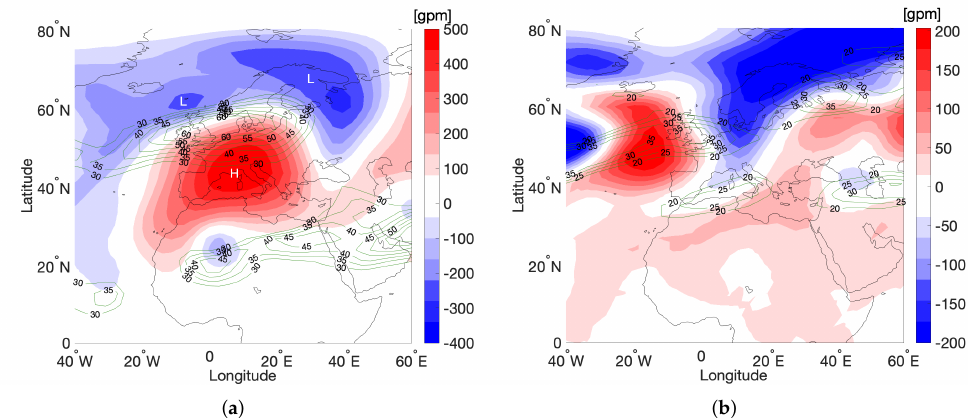
Figure 7. Daily mean geopotential height anomaly (red–blue contours, in geopotential meter (gpm)) and zonal wind speed (green contours with interval 5 m/s) at 250 hPa for ( a ) 1 February 2016, with wind speeds from 30 to 60 m/s, ( b ) 1 August 2016, with wind speeds from 20 to 35 m/s. “H” and “L” represent the high and low geopotential height